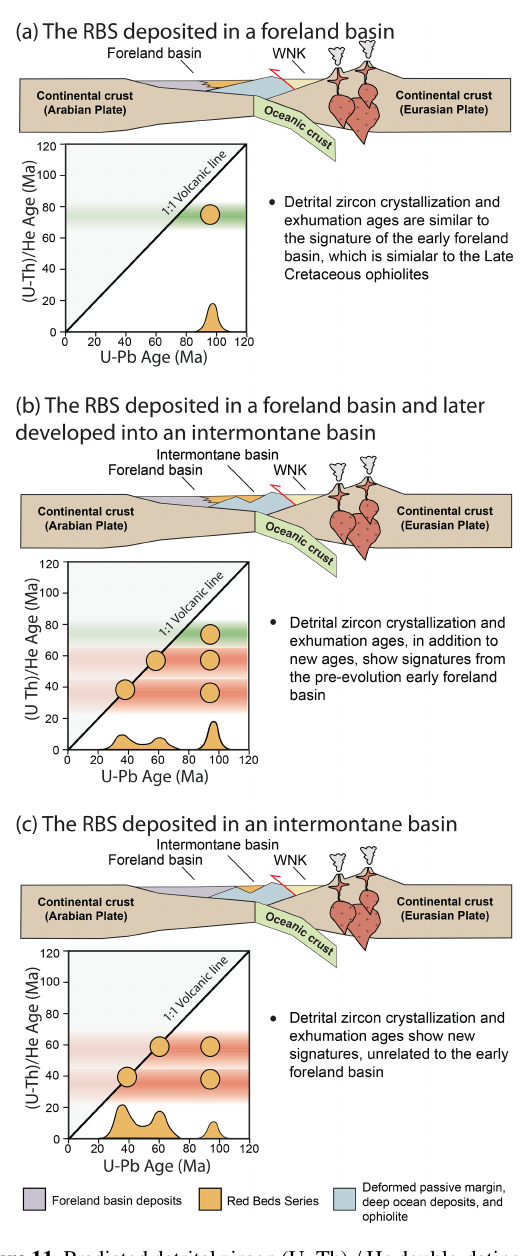
Figure 11. Predicted detrital zircon (U–Th) / He double-dating ages for the competitive hypotheses of the Red Beds Series depositional setting: (a) a foreland basin; (b) a foreland basin, but later parti- tioned and evolved into an intermontane basin; (c) an intermontane